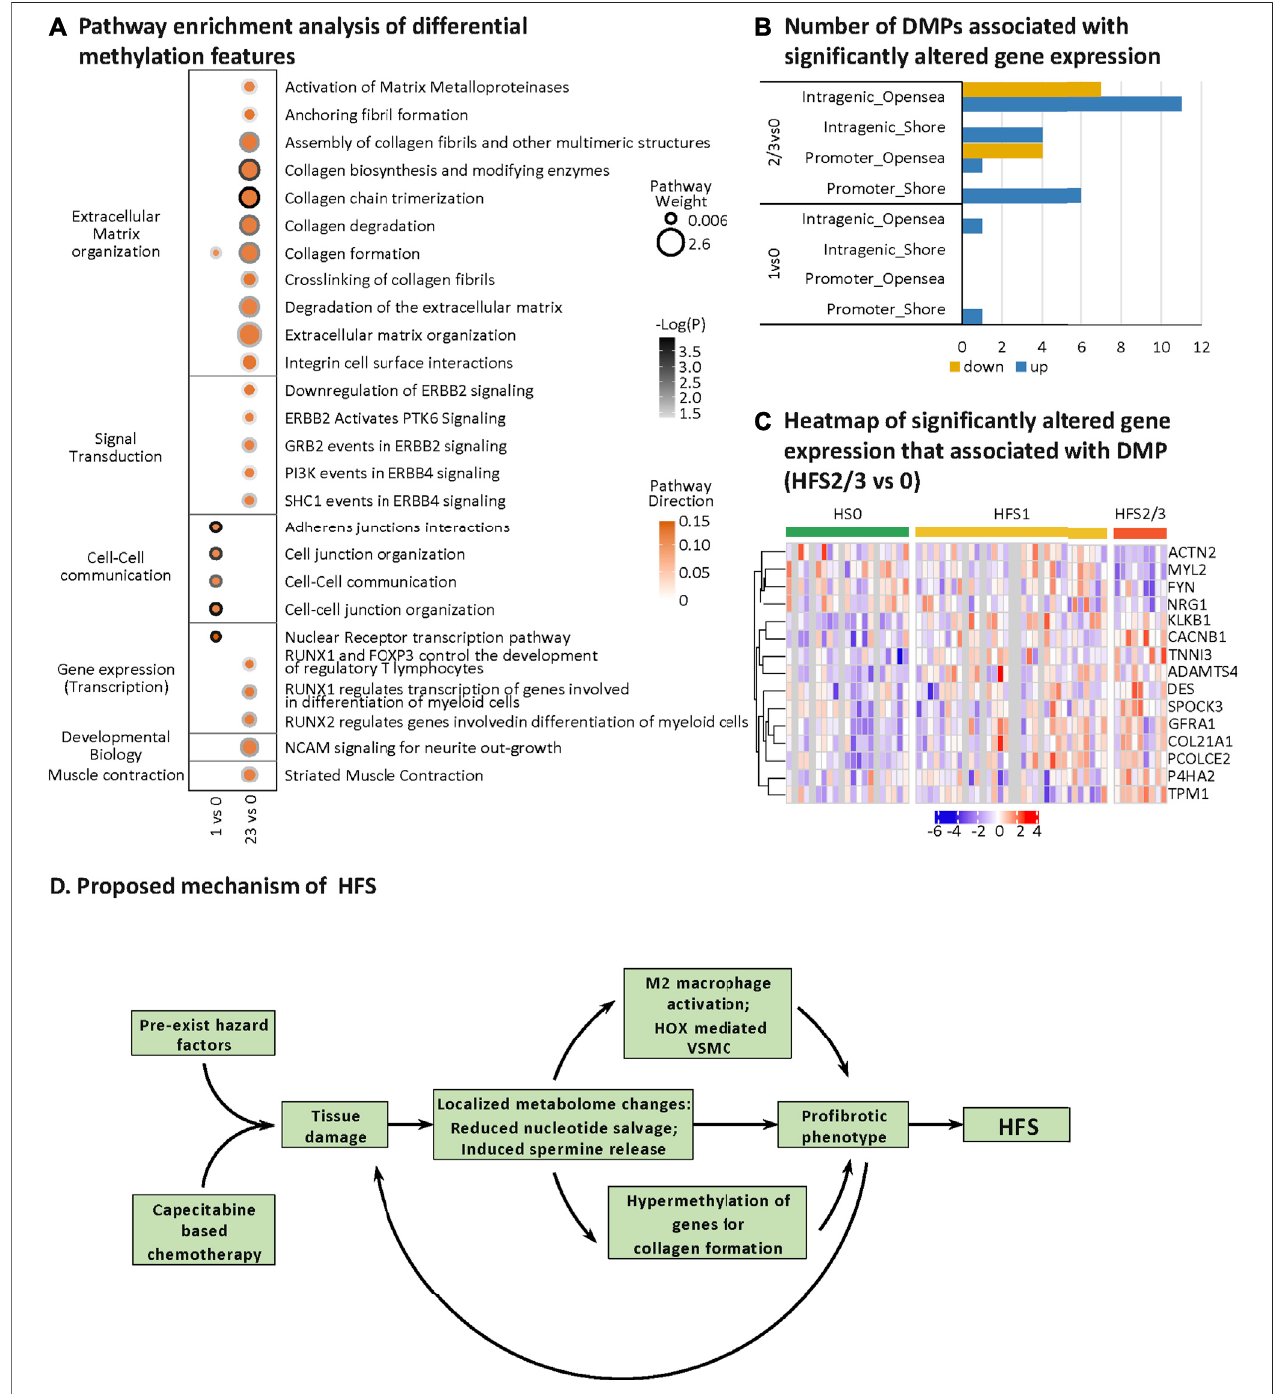
FIGURE7| HFS-relatedDNAmethylationchangesandaproposedmechanismofchemotherapy-inducedHFS. (A) Pathwayenrichmentanalysisofdifferentiallymethylated genes(containingdifferentiallymethylatedprobes,DMPs).DMPsinopenseaorshoreregionswereselectedforthepathwayenrichmentanalysis.Cutoff:theminimumnumberof DMPsenrichedinthepathwaywassetas5,andthe p -valuewassetas0.05.Thedotbordercolorrepresentsthe – log10(P)ofpathwaysigni fi cance.Pathwayweightisde fi nedas: (Enrichment ratio) × (sum of absolute value of DMP MOFA LF1 weight in the pathway), and the dot size represents pathway weight. Pathway direction is the median Δβ of DMPsinthepathway(red,hypermethylated;green,hypomethylated).Notes:Asforpathwaydirection,inthecaseofDMPsmappedtomultipleregions(ninetypesofGDMR,gene- function-DMR:threegene-function,andthreeCpG-island-basedregions),pathwaydirectionisbasedonthedirectionoftheregionwiththehighestsumofabsoluteDMPMOFA L1weightinthepathway. (B,C) Differentialmethylation – relatedtranscriptionalchanges.NumberofDMPsassociatedwithsigni fi cantlyalteredgeneexpression (B) andheatmapof signi fi cantlyalteredgeneexpressionthatassociatedwithDMP(HFS2/3vs0) (C) . (D) ProposedmechanismofHFS.Abbreviation:DMPs,differentiallymethylatedprobes.Notes: The nine types of GDMR were: 1) promoter-island regions, 2) promoter-shore/shelf regions, 3) promoter-opensea regions, 4) intragenic-island regions, 5) intragenic-shore/shelf regions, 6) intragenic-opensea regions, 7) intergenic-island regions, 8) intergenic-shore/shelf regions, and 9) intergenic-opensea regions.